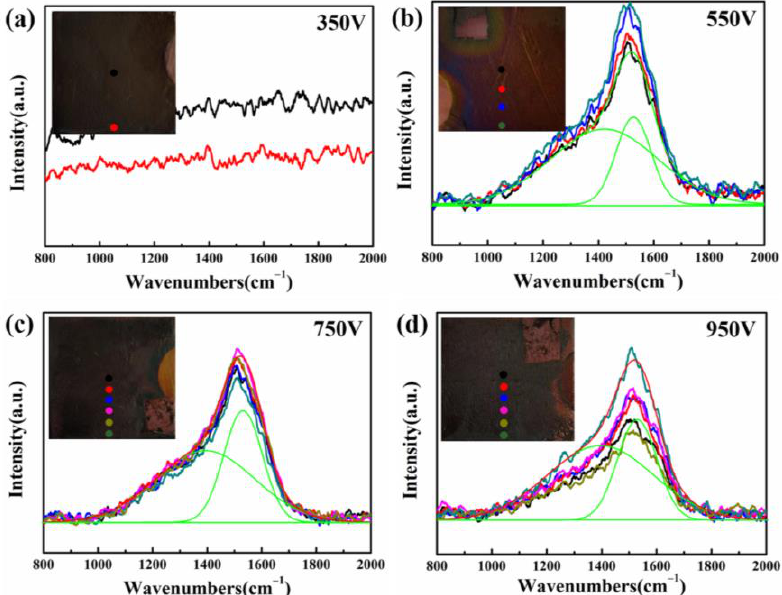
Figure 3. Raman spectra of the films prepared on Ti/PMMA at different substrate bias of ( a ) 350V, ( b ) 550V, ( c ) 750V and ( d ) 950V with conductive material. The color of the Raman curve represents the results measured at the corresponding color position in the illustration.